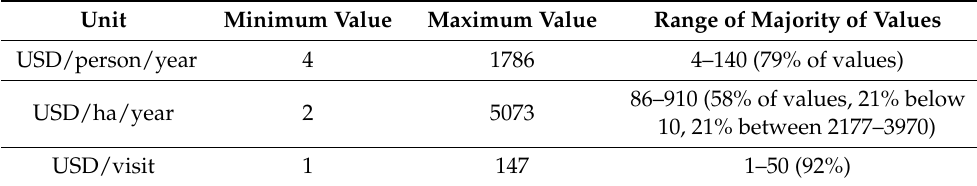
Table 1. Distribution of values for recreational services of